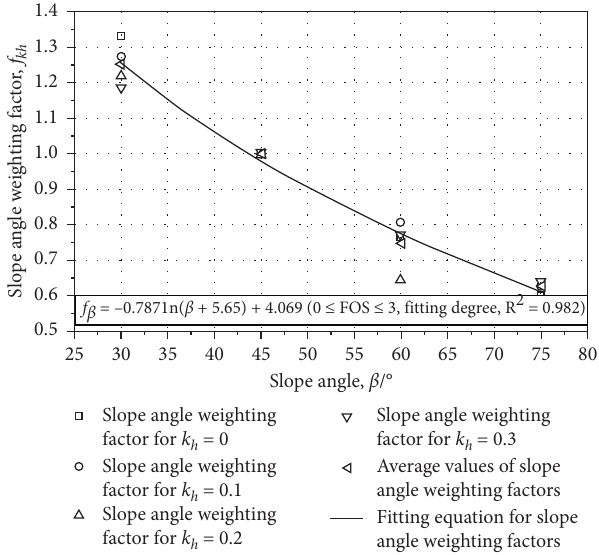
Figure 11: The chart for the slope angle weighting factor. Table 4: Three slope examples analyzed using the proposed seismic stability